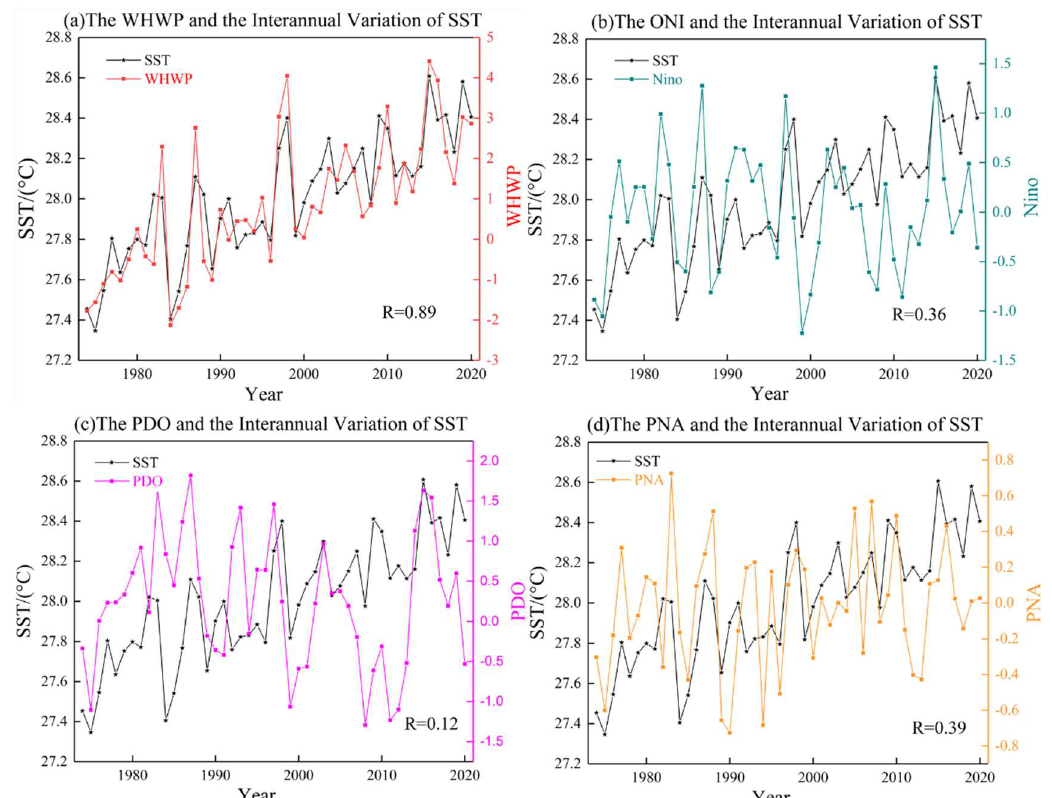
Figure 17. Interannual variation of SST in tropical western Indian Ocean. ( a ) WHWP and SST; ( b ) ONI and SST; ( c ) PDO and SST; ( d ) PNA and SST.